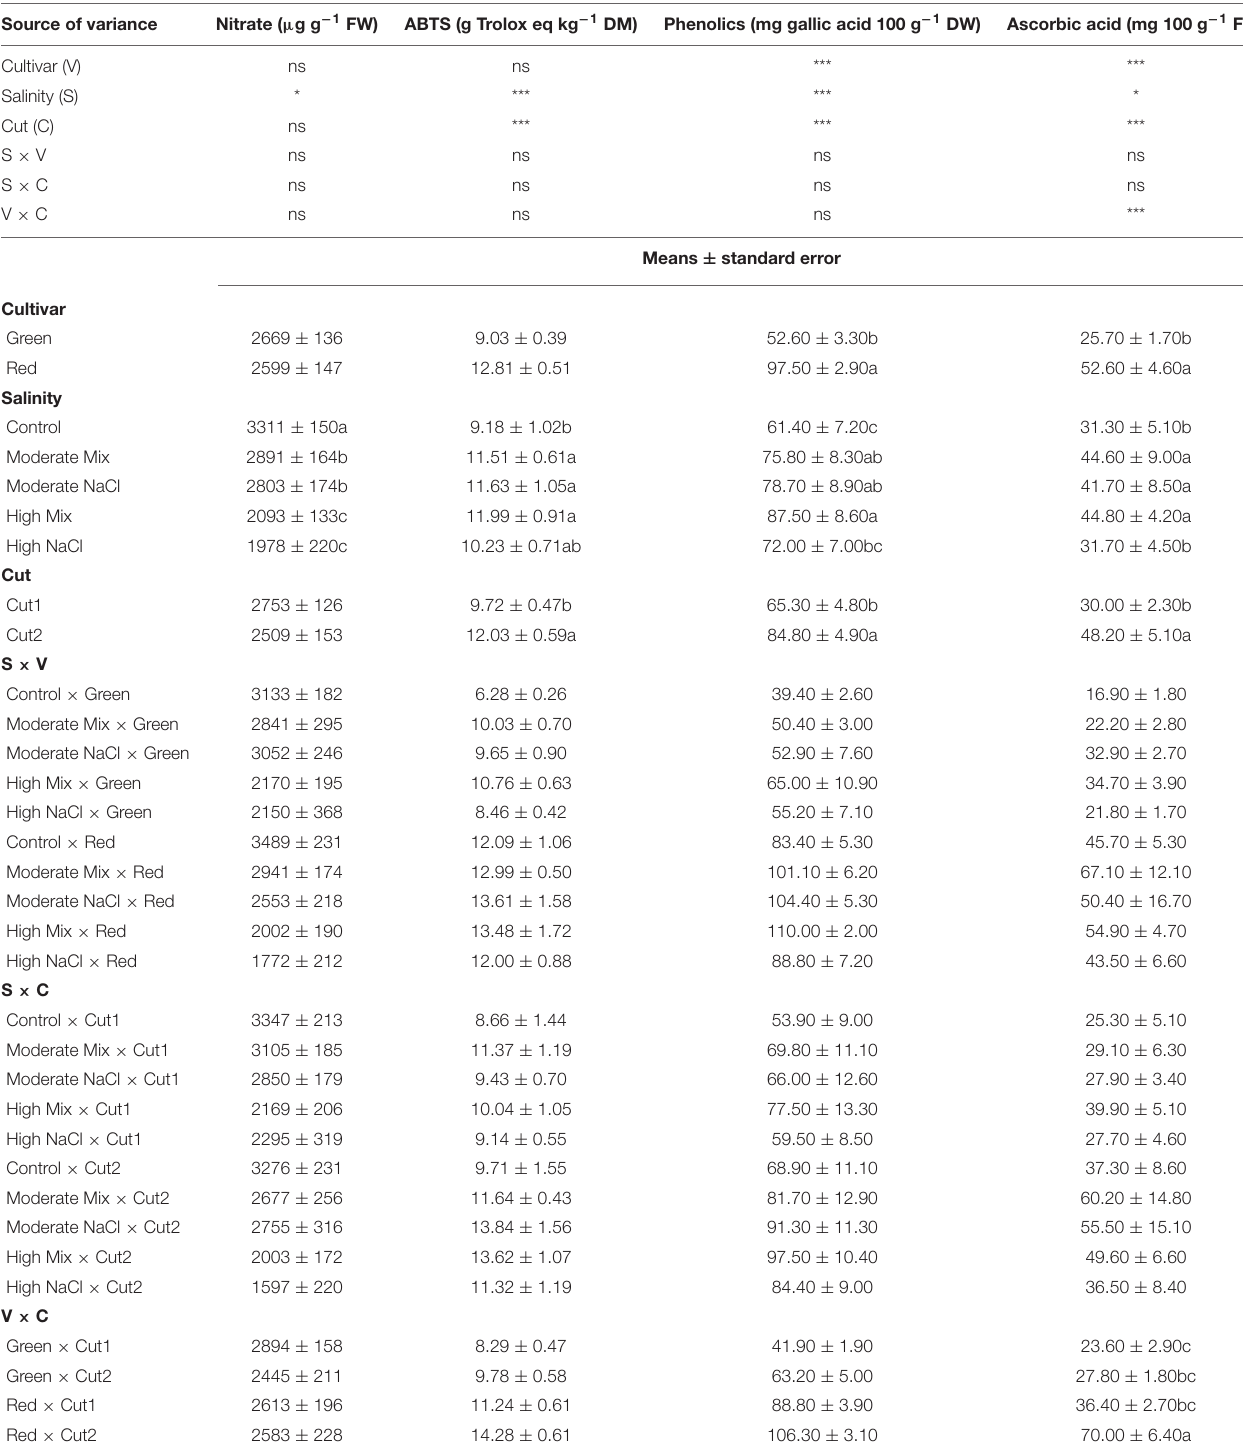
TABLE 5 | Analysis of variance (ANOVA) and mean comparisons for nitrate concentration, ABTS antioxidant activity, total concentration of phenolic compounds, and ascorbic acid concentration of Green and Red cultivars grown hydroponically under iso-osmotic salinity treatments and harvested in two sequential cuts. Source of